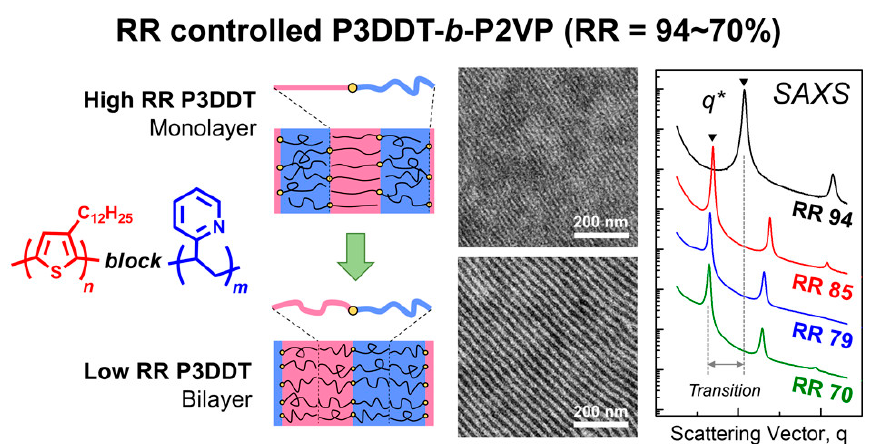
Figure 14. Chemical structure of P3DDT- b -P2VP and their morphological results from TEM and SAXS characterization. (Reprinted with permission from Ref. [121]. Copyright American Chemical